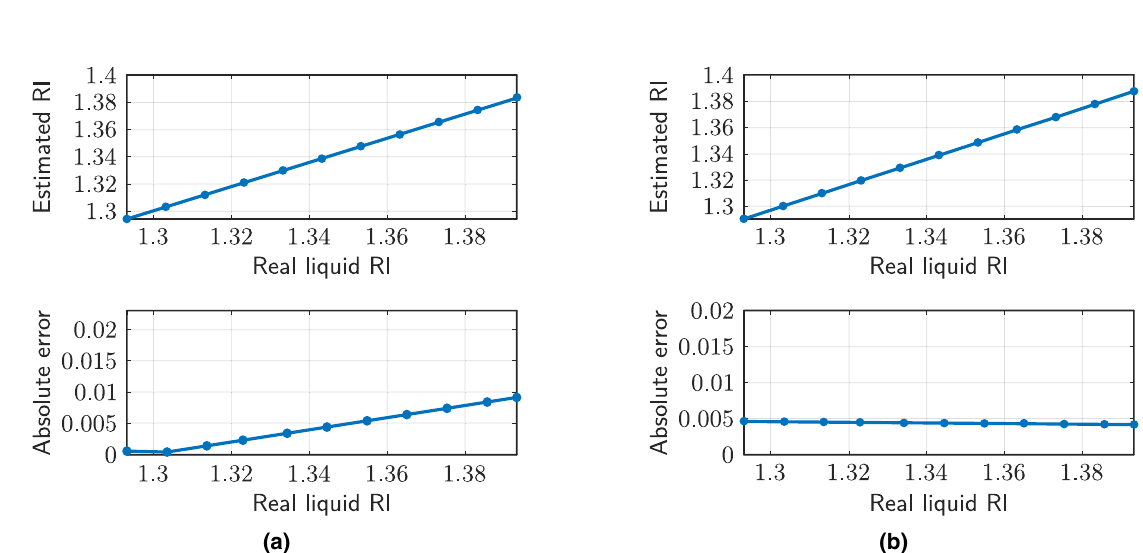
Figure 11. ( a ) Estimated refractive index of the HCF liquid whose level is at 300 µ m. ( b ) Estimated refractive index of the HCF liquid whose level is at 1300 µ